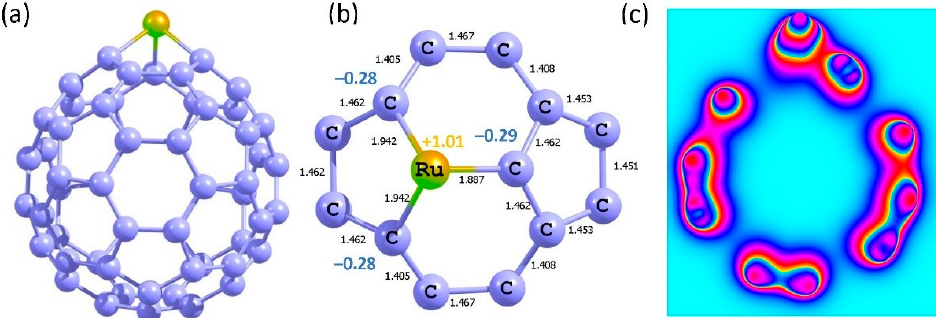
Figure 9. ( a ) Relaxed structure of Ru-doped C 60 , ( b ) bond distances and Bader charges on the Ru and its adjacent C atoms and ( c ) charge density plot showing the interaction of Ru with the